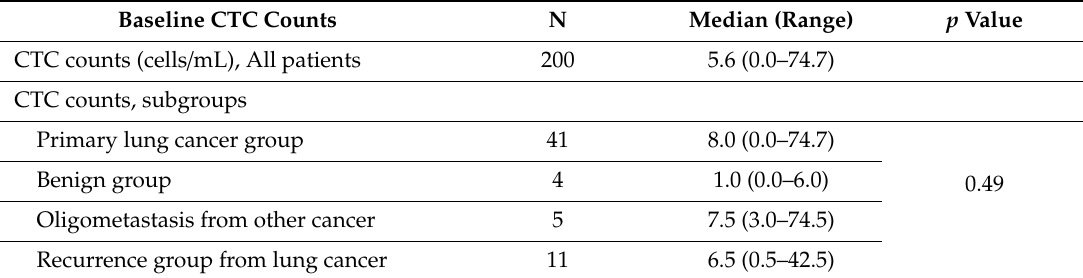
Table 2. Circulating tumor cell counts in all patients and di ff erent groups. CTC, circulating tumor